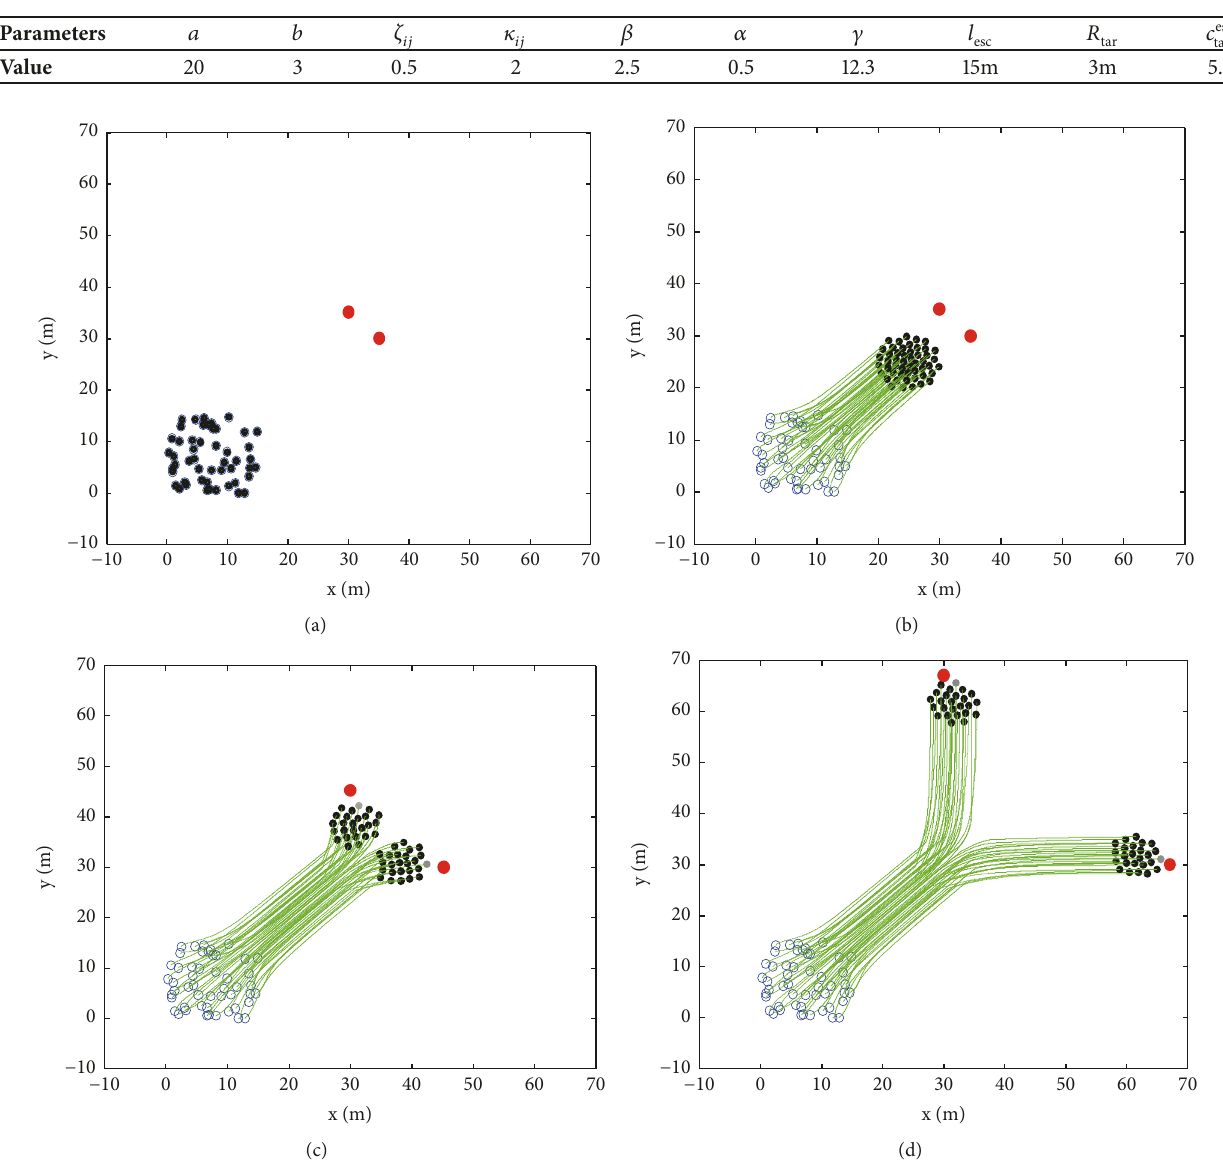
Table 1: Parameters in the simulation.